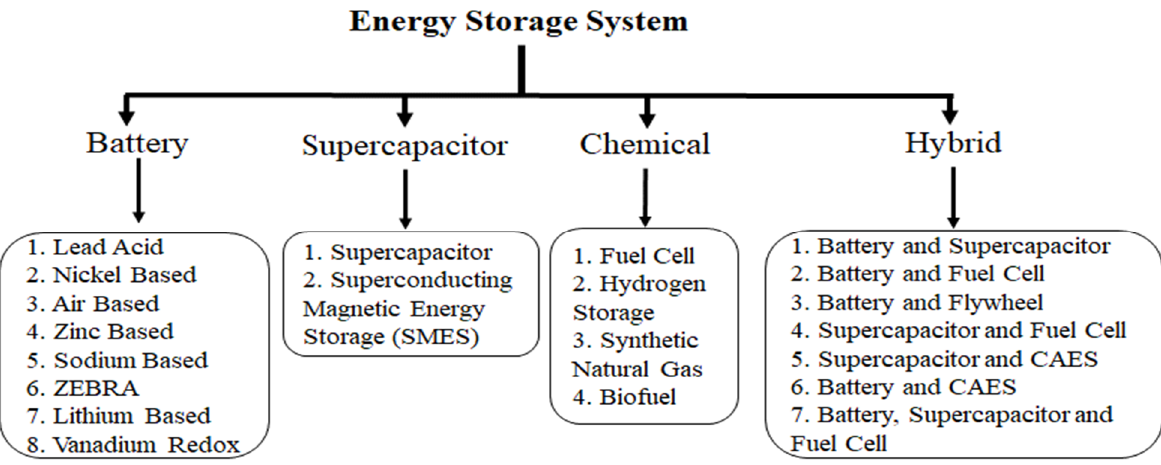
Figure 5. EV-applicable energy storage system [2].